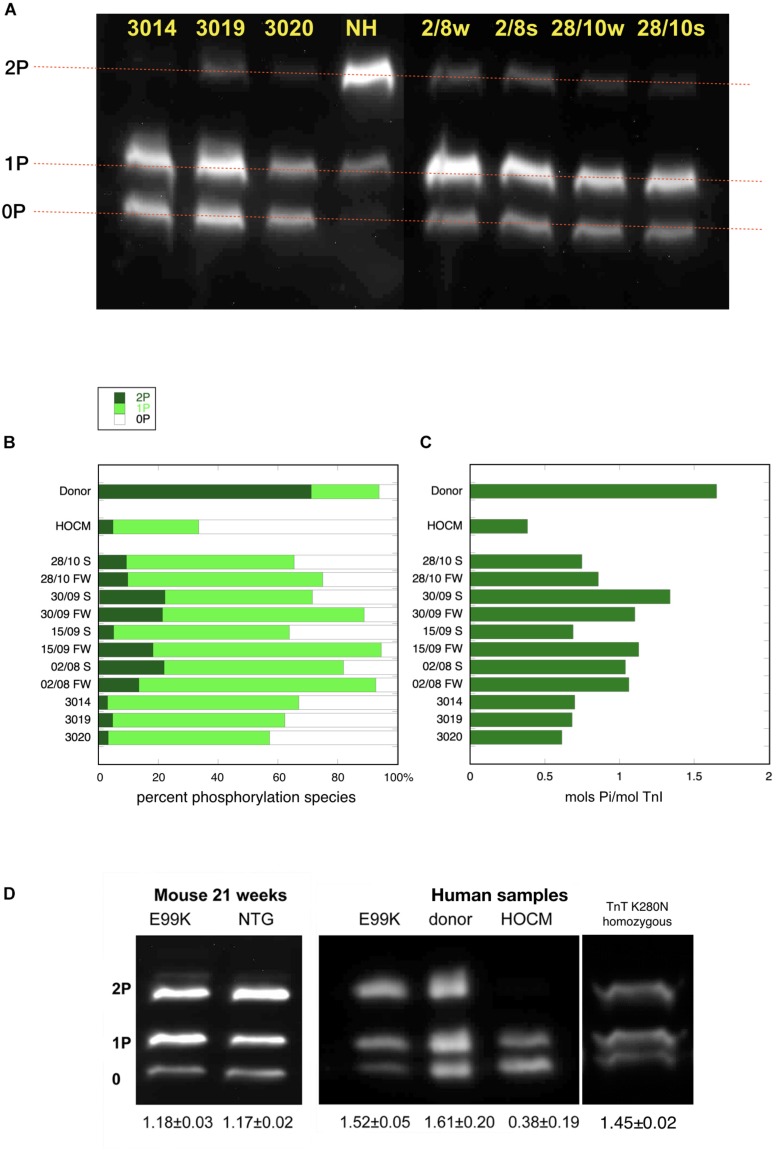
Phosphate affinity SDS-PAGE separation of myofibrils, probed with antibody 14G5 to troponin I. (A) Example of separation of phosphospecies. Phosphorylated protein is retarded in proportion to level of phosphorylation yielding discrete bands for bis- mono- and unphosphorylated troponin I. NH is a donor heart sample showing a high level of 2P species. The other lanes are aortic stenosis samples which show high level of 1P and 0P species. (B) Distribution of 2P, 1P, and 0P species in heart muscle samples. The results for each sample are the means of 2–4 replicate assays. S, septum; FW, free wall. Donor heart NH and HOCM heart MV control results are the mean of replicates included in the same gels as the pressure overload samples. Full data is shown in Supplementary Table 2. (C) Calculated total phosphorylation level for these samples. (D) Phosphate affinity SDS-PAGE of ACTC E99K mouse, ACTC E99K human heart and TNNT2 K280N human heart samples with donor and HOCM controls. Total phosphorylation is shown below underneath each lane.